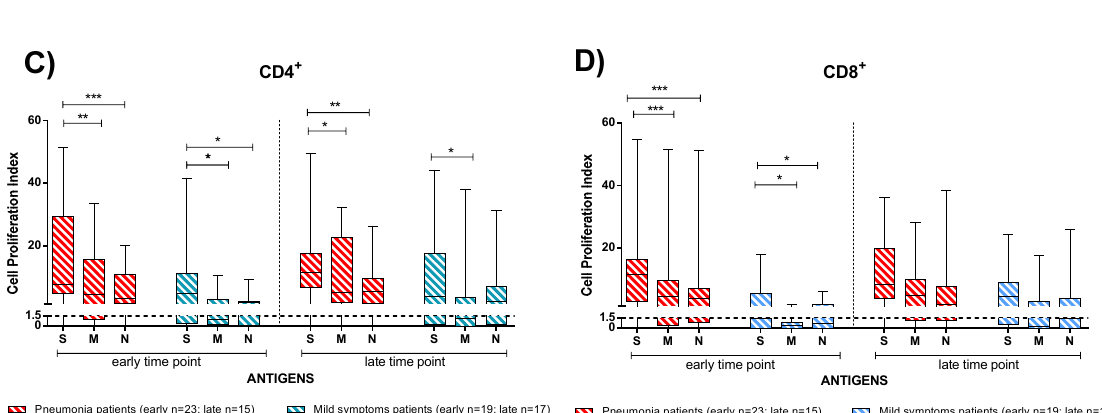
Figure 5. The T-cell dominant specificity after stimulation with Spike (S), Membrane (M), and Nucleocapsid (N) peptide pools in patients with pneumonia or mild symptoms at early and late time points (immunocompetent and transplanted were considered together). ( A ) Antigen-specific CD4 + T-cells and ( B ) CD8 + T-cells (rapid Activation Induced Marker assay); ( C ) CD4 + T-Cell Proliferation Index; ( D ) CD8 + T-Cell Proliferation Index. Early time point: patients with pneumonia, median 59 (range 30–100) days after infection; patients with mild symptoms, 52 (26–100) days after infection. Late time point: patients with pneumonia, median 220 (range 164–400); days after infection; patients with mild symptoms, 189 (150–306) days after infection. * p < 0.05; ** p < 0.01; *** p < 0.001.